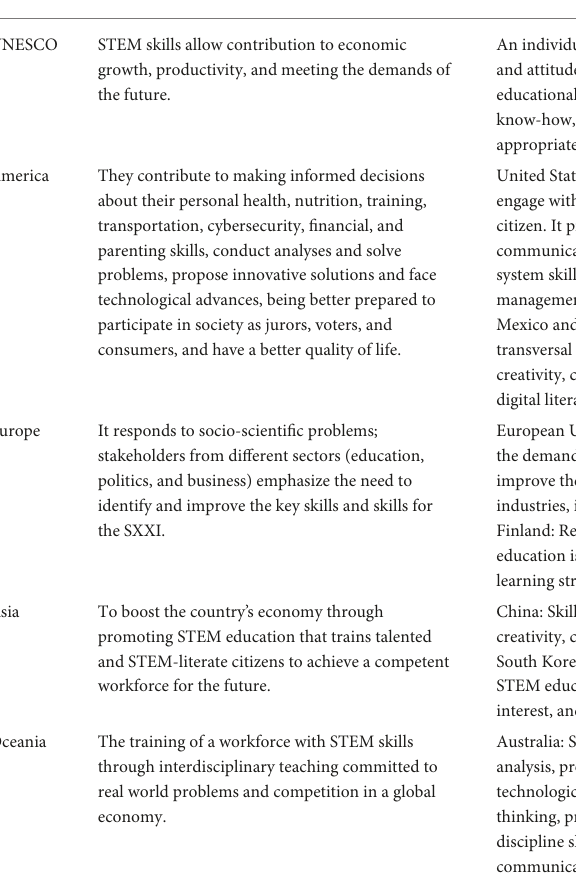
TABLE 1 Review of STEM skills and STEM education. STEM skills refer to .